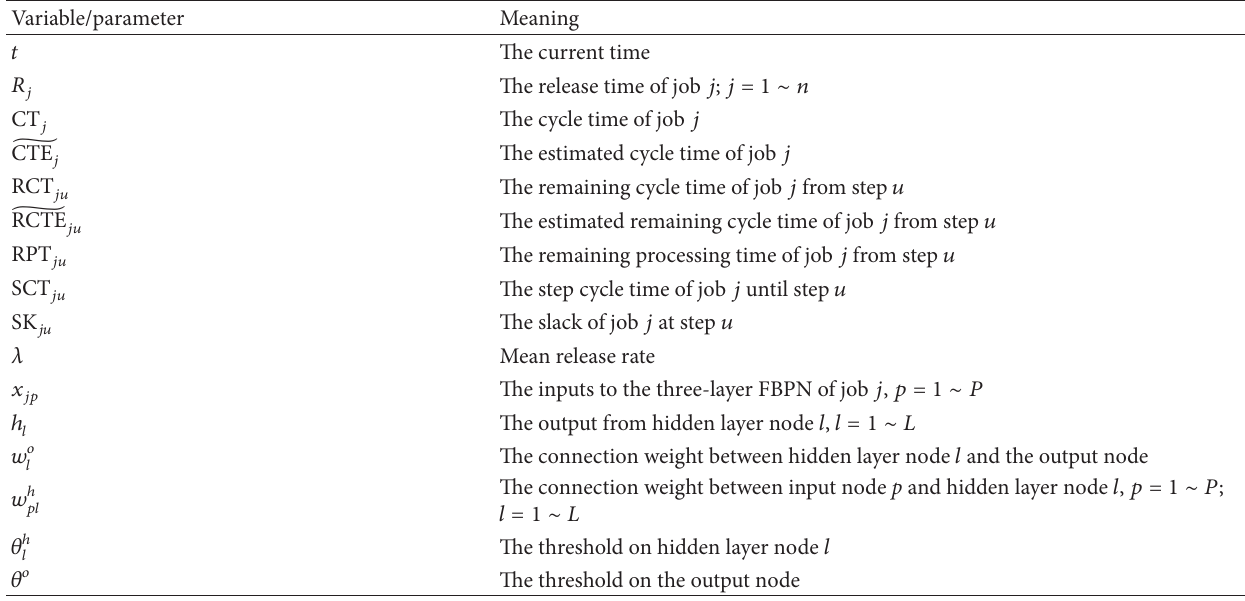
Table 4: The nomenclature table.